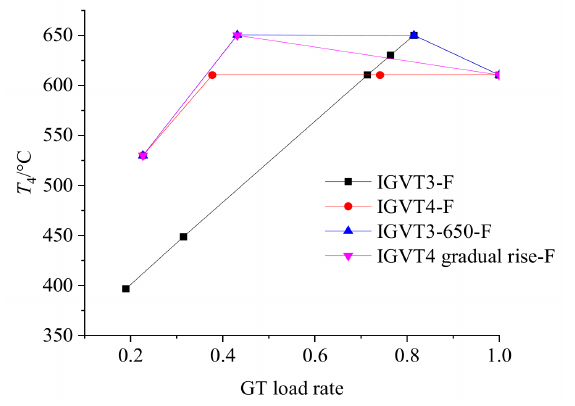
Figure 4. Outlet temperature of the GT ( T 4